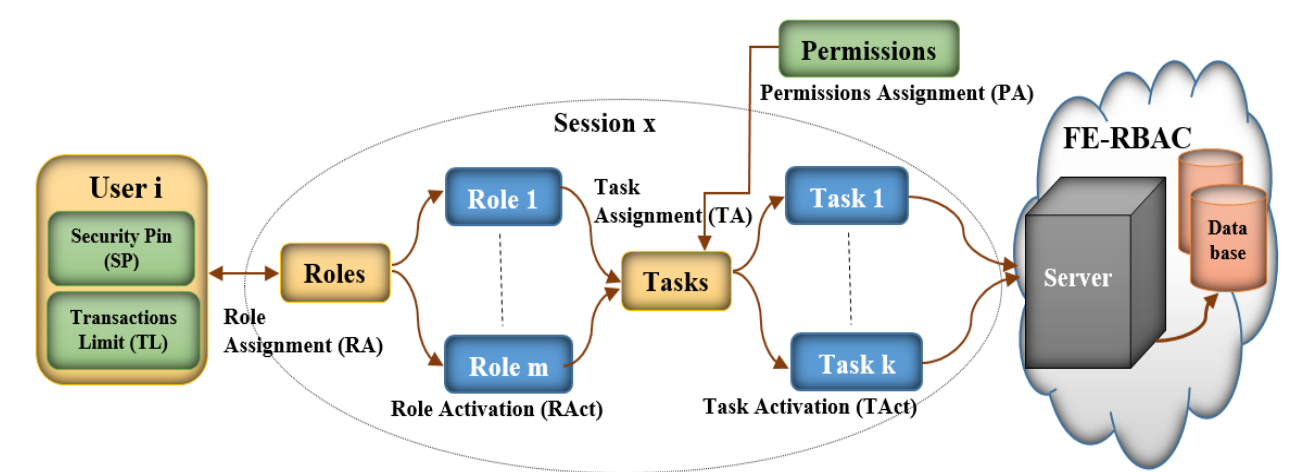
Figure 1. Efficient and Flexible Role-Based Access Control